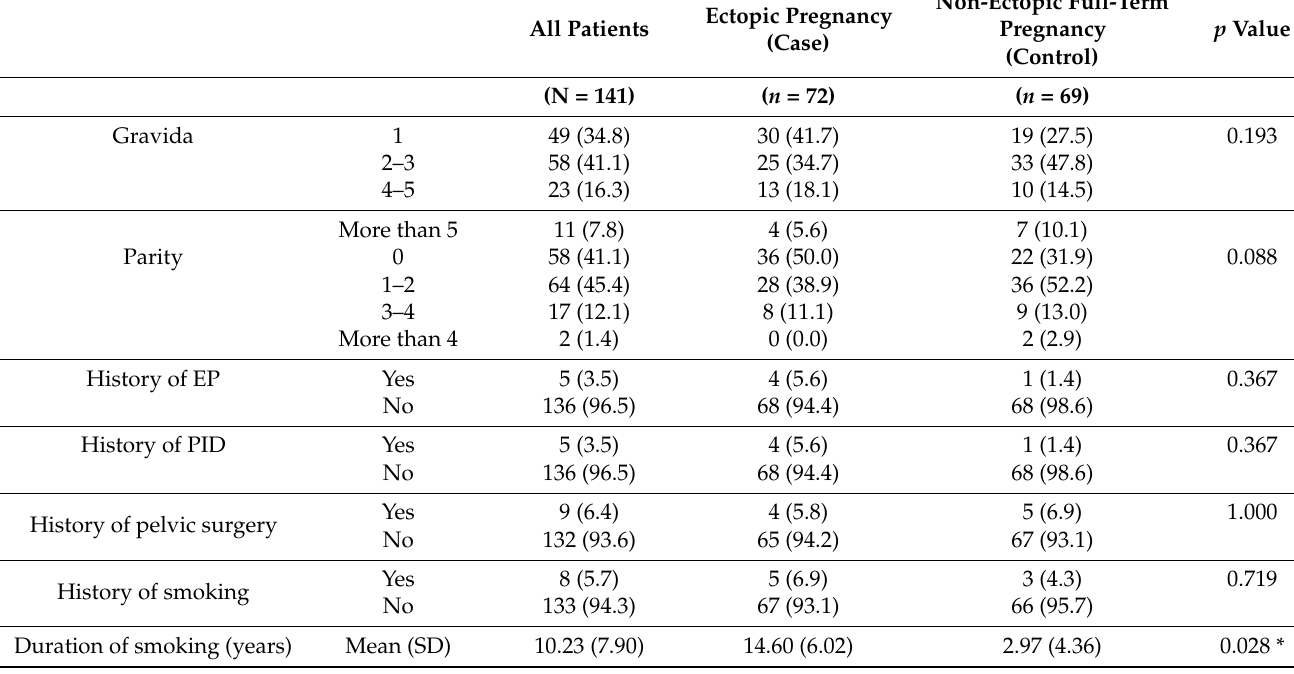
Table 2. Clinical characteristics of the study patients (N =